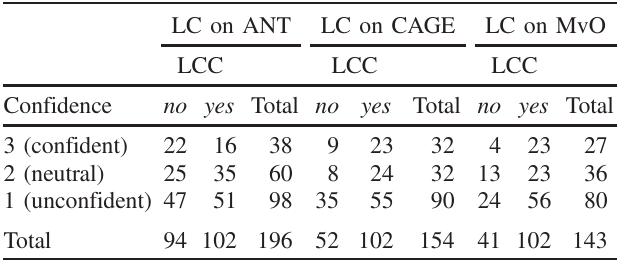
TABLE III. Confidence level of students who were assigned a level confusion code on ANT (left), CAGE (middle), and/or MvO (right). Out of N ¼ 234 respondents, 102 received a LC code on all three isomorphic prompts. These are the respondents with LCC ∶